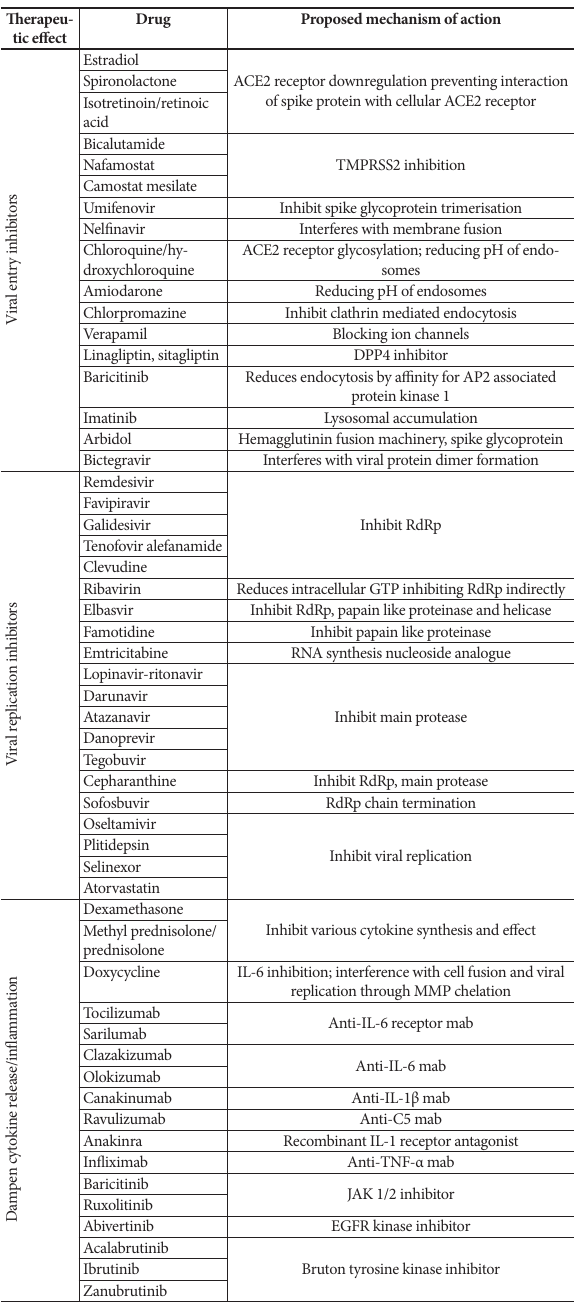
Table 3. Drugs repurposed for Covid-19. Therapeu- tic